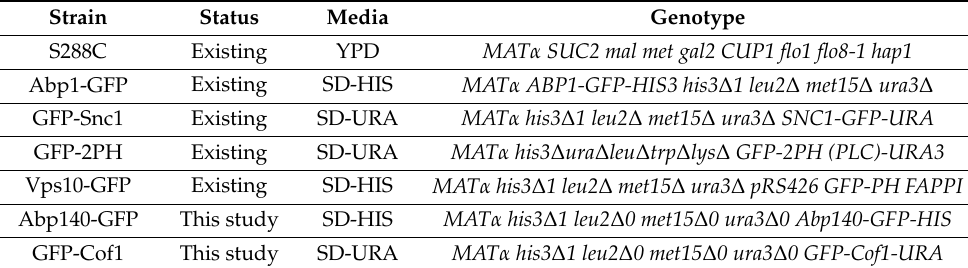
Table 1. Yeast strains used in this